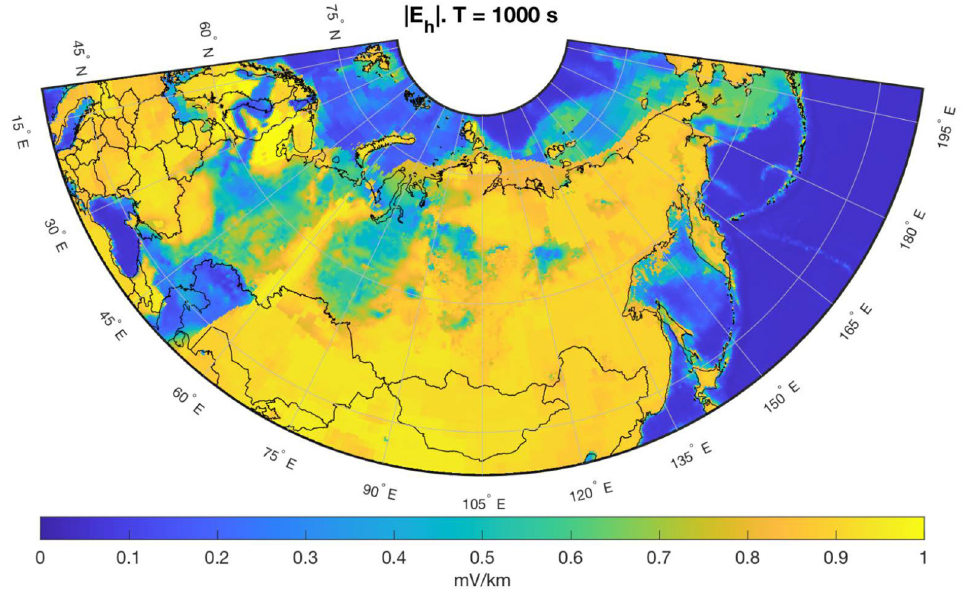
Figure 11. Map of the horizontal geoelectric field magnitude | E H |, excited by a uniform magnetic field with period T = 1000 s and magnitude of 1 nT.